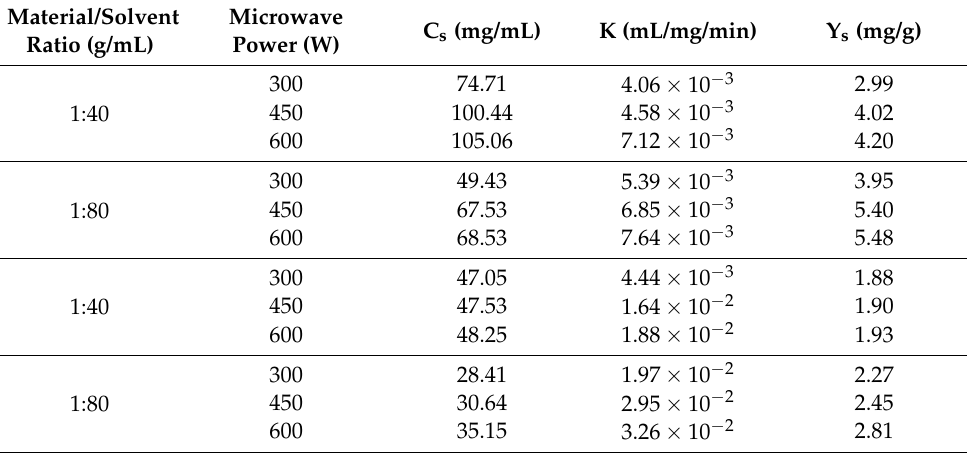
Table 1. Nonlinear regression analysis of mathematical models in both chlorophyll a and b extraction kinetics by MAE